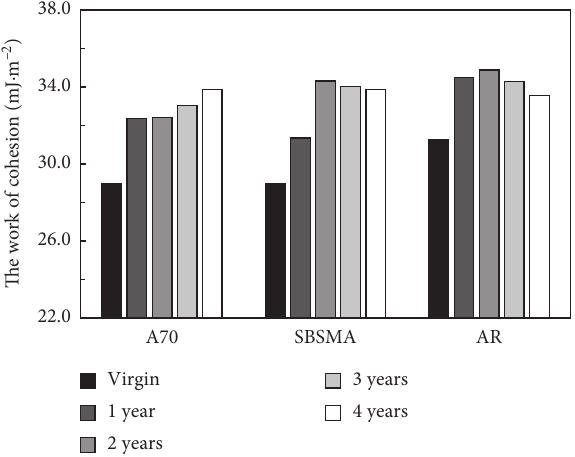
Figure 6: Work of cohesion of asphalt. Table 8: Surface free energy components of